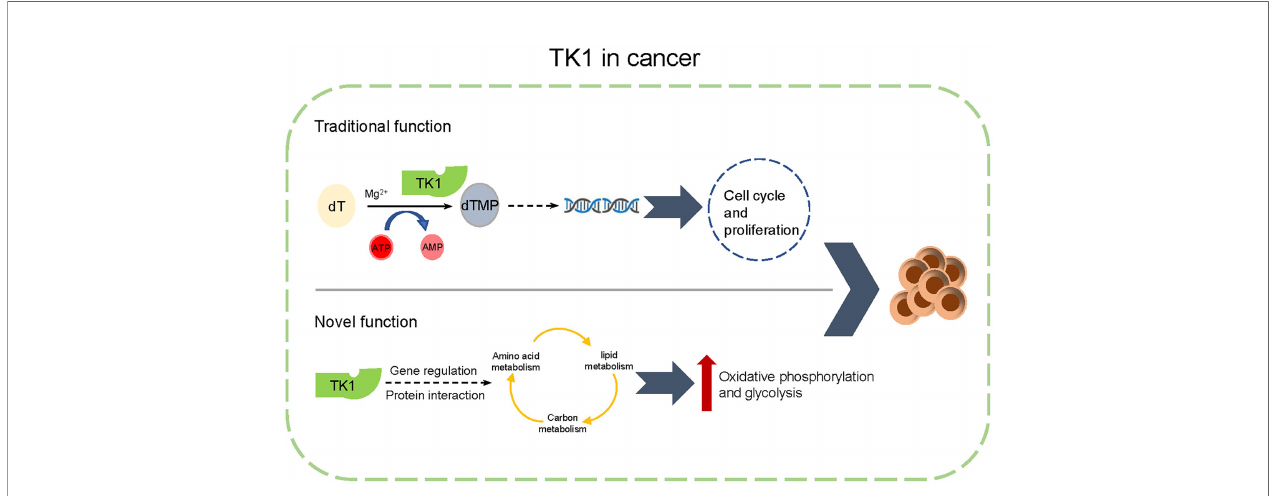
FIGURE 8 | A schematic diagram of functions of thymidine kinase 1 (TK1) in skin cutaneous melanoma